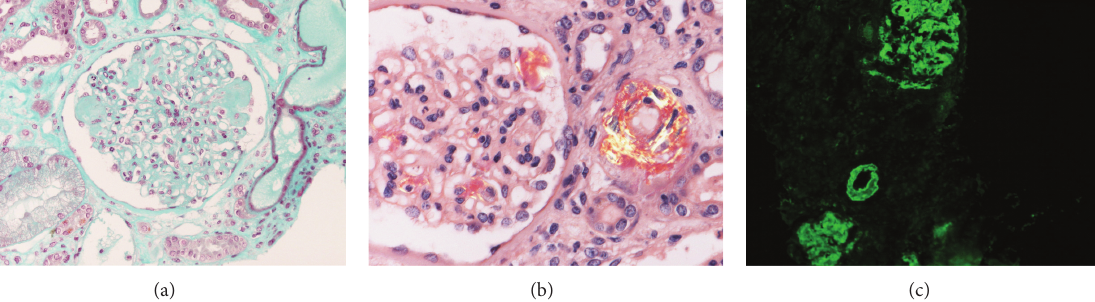
Figure 1: Histopathological findings of kidneys. (a) nodular appearance due to amorphous acellular mesangial deposition (Masson trichrome stain; magnification, × 200). (b) accumulation of amyloid expanding the mesangial area and the arteriole (Congo red stain viewed by polarized light microscopy), (c) immunohistochemically positivity of AA amyloid (avidin-biotin-peroxidase complex system; original magnification, ×